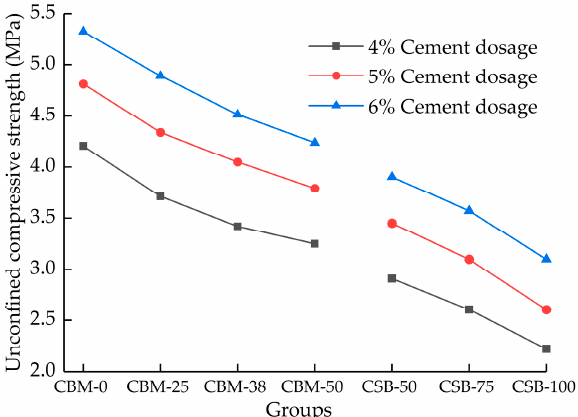
Figure 8. The unconfined compressive strength of mixture with different cement dosage at 7 days.